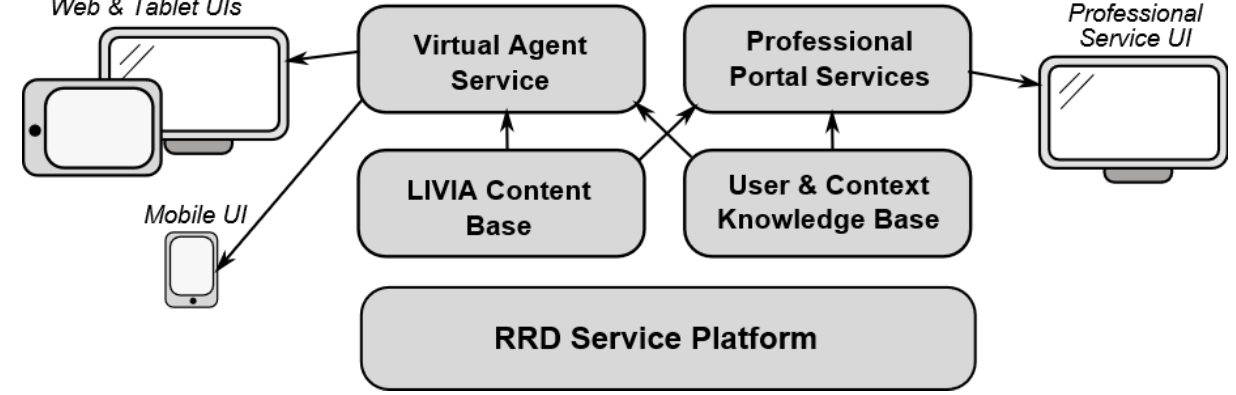
Figure 5. LEAVES (optimizing the mentaL health and resiliencE of older Adults that haVe lost thEir spouSe via blended, online therapy) service component overview. UI: user